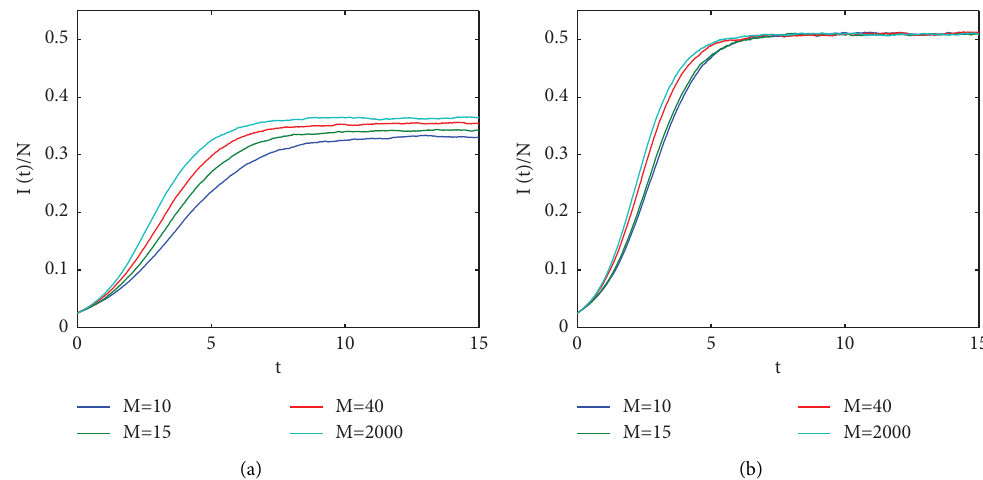
Figure 2: Time dependence of the densities of infectious nodes for diferent values of M . Te lines are averaged over 200 stochastic simulations according to the algorithm of epidemic spreading on evolving networks in Section 3.2, with the parameter values being N � 2000, λ � 0 . 3, c � 1, m � 8, p � 0, (a) μ � 0 . 5, and (b) μ � 0 .